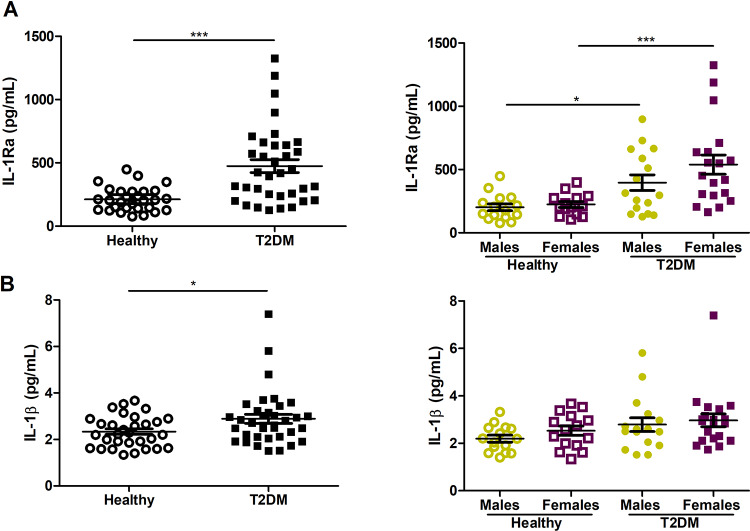
Plasma levels of cytokines in type 2 diabetes mellitus (T2DM, n = 35) patients and healthy controls (Healthy, n = 30).(A) Levels of IL-1Ra in all subjects and males/females; (B) Levels of IL-1β in all subjects and males/females. Results are expressed as mean ± SEM. *P< 0.05, ***P< 0.001.